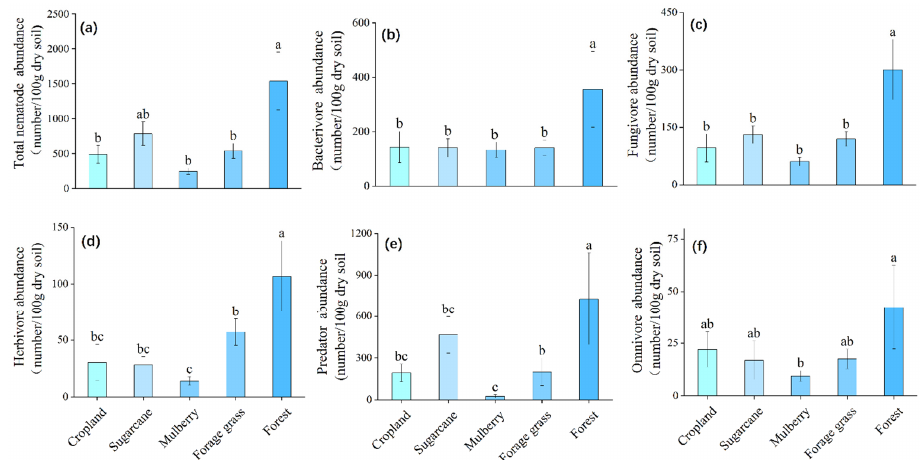
Figure 2. Abundances of total nematodes and different nematode trophic groups in the cropland, sugarcane, mulberry, forage grass, and forest. ( a ) Total nematodes; ( b ) bacterivores; ( c ) fungivores; ( d ) herbivores; ( e ) predators; ( f ) omnivores. Values are mean ±SE. Within each panel, values with the same or no letters are not significantly different ( p > 0.05) according to the LSD test.